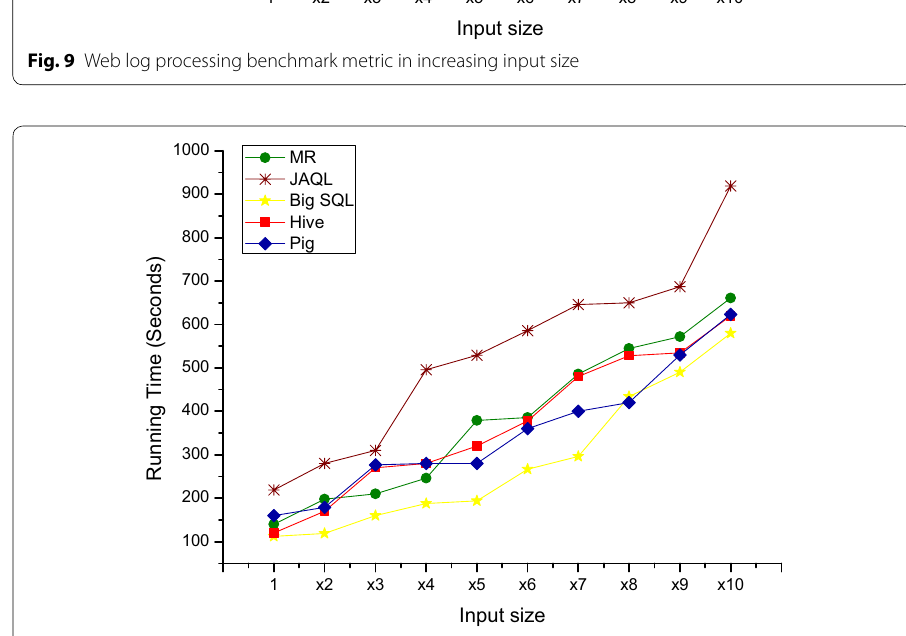
Fig. 10 Join benchmark metric in increasing input